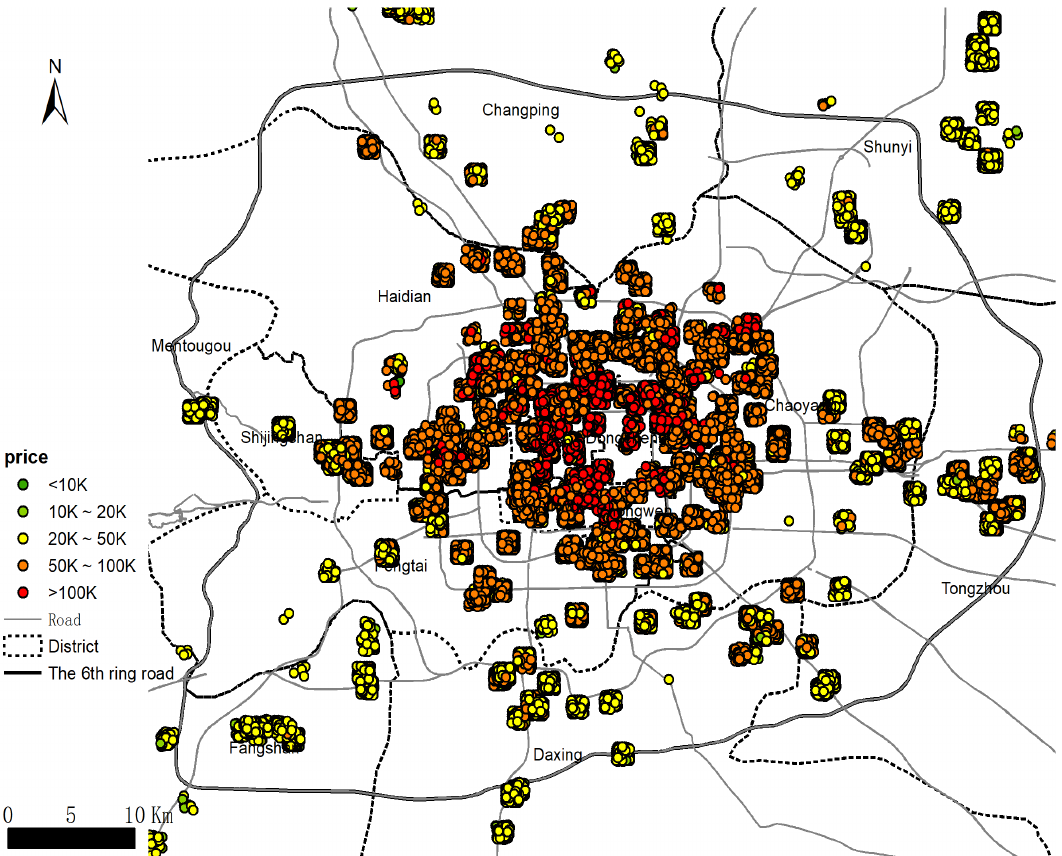
Figure 1. Study area and spatial distribution of